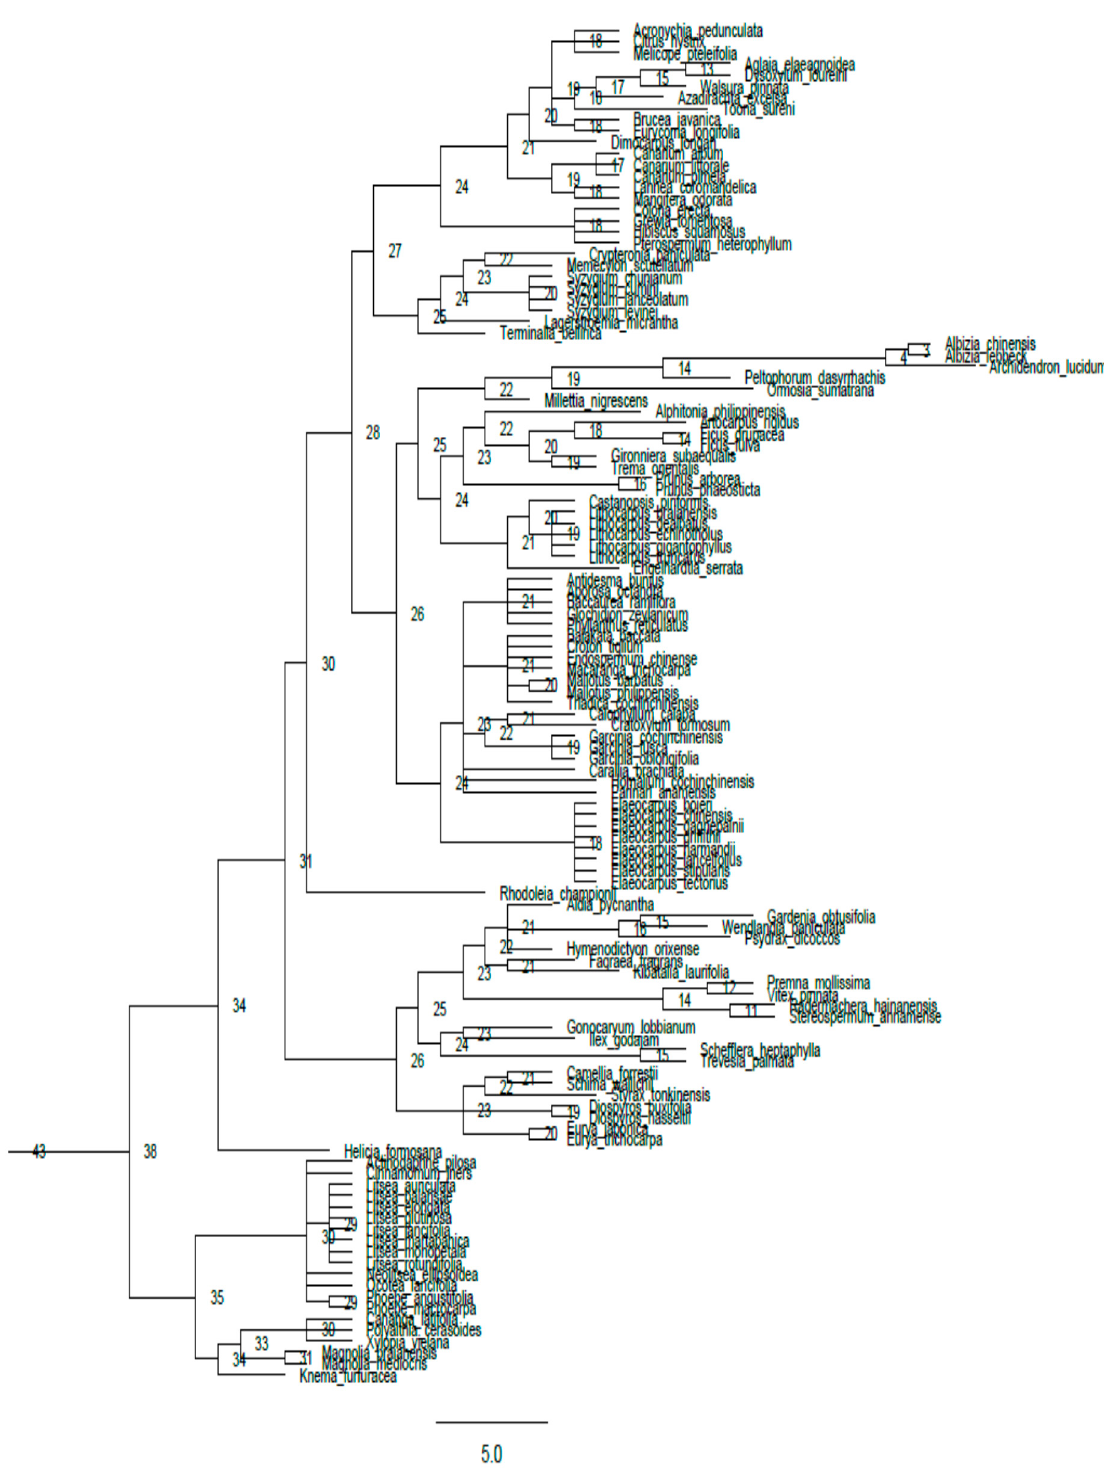
Figure A3. Phylogenetic tree of SF2.